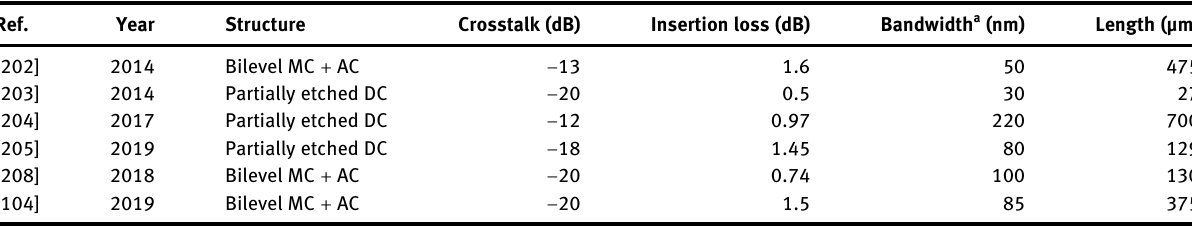
Table  : Survey of PSRs on SOI with SiO  cladding near  nm.